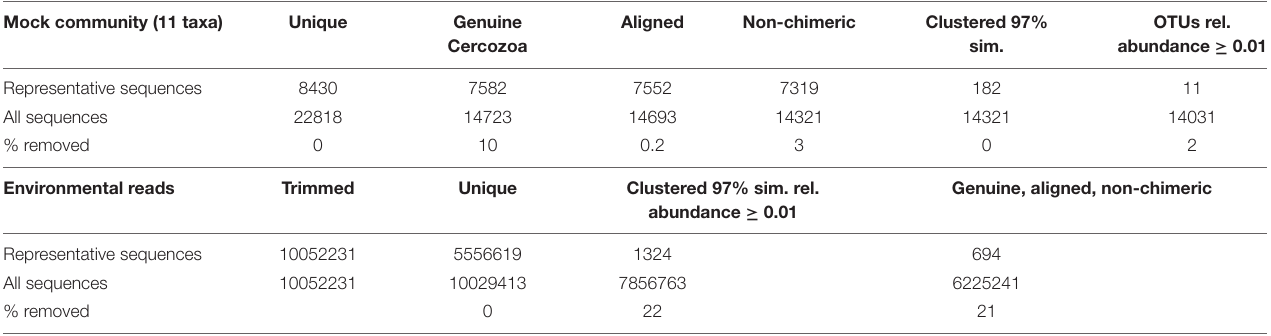
TABLE 1 | Number of reads retrieved at each step of the bioinformatic pipeline. Mock community (11